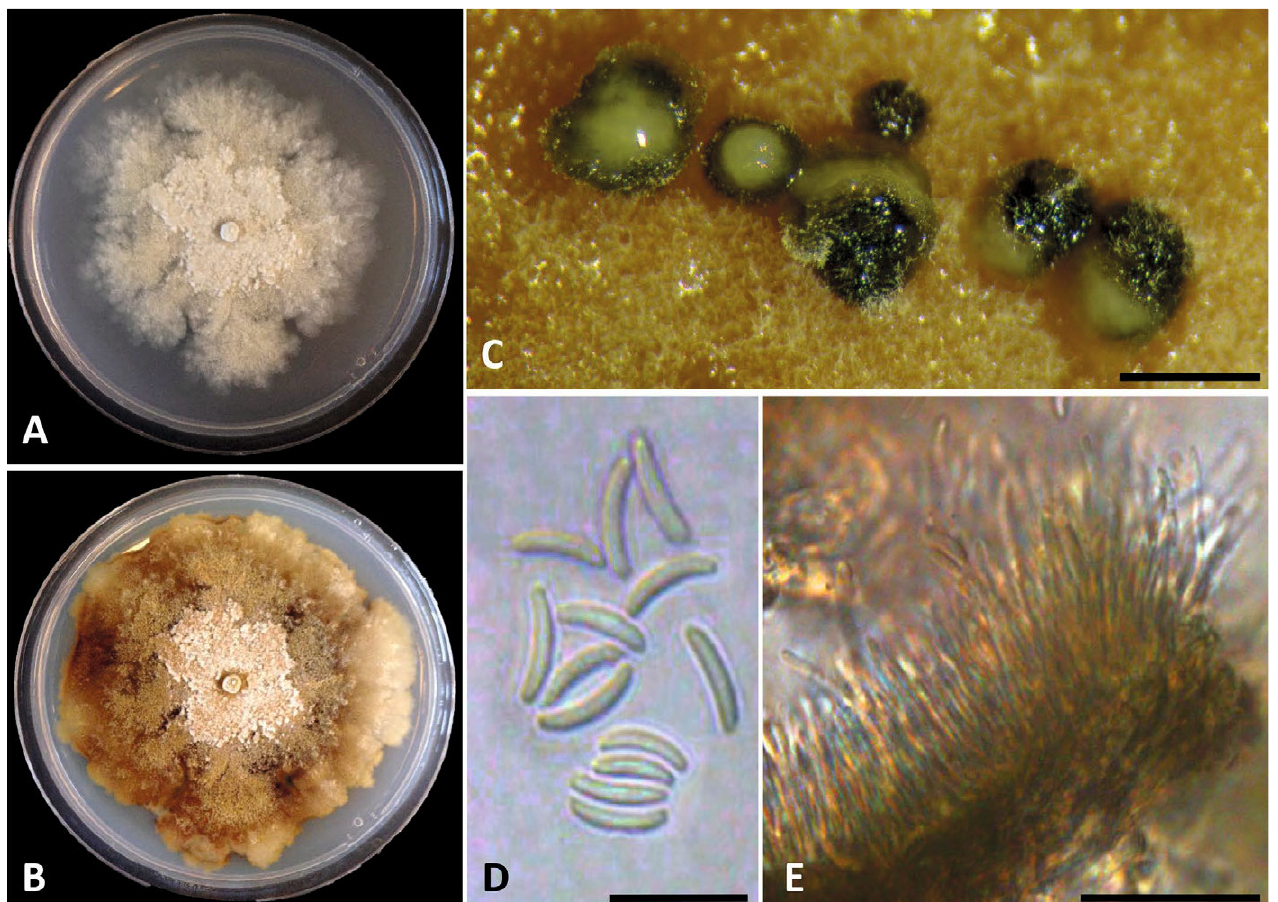
Fig. 11. Cytospora longispora (ex-holotype culture CBS 144236). A. Seven-day-old PDA culture. B. Fourteen-day-old PDA culture. C. Pycnidia. D. Conidia. E.